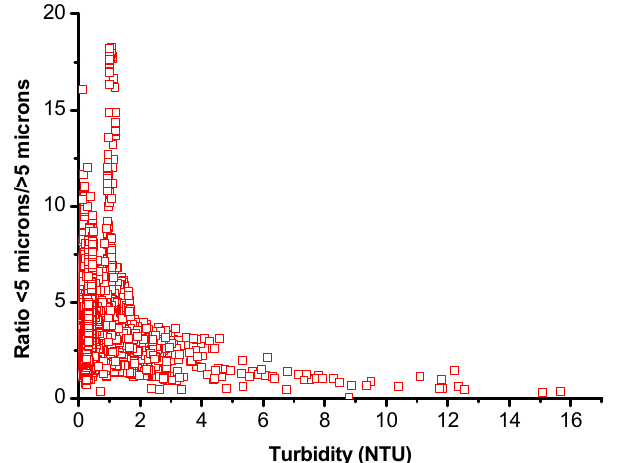
Figure 4. Graph of the ratio of the number of particles/mL less than 5 microns to the number of particles/mL greater than 5 microns with respect to turbidity.